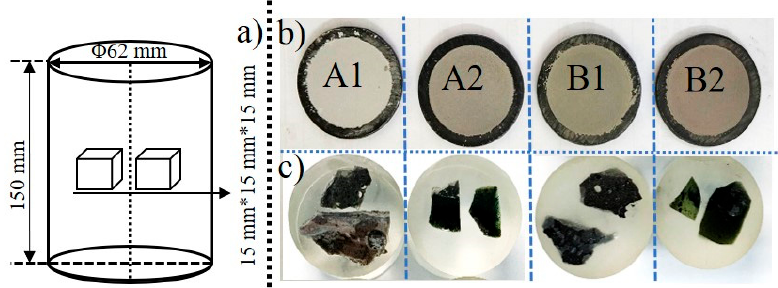
Figure 1. The scheme of obtaining and the appearance of test samples: ( a ) schematic diagram of the metallographic specimen; ( b ) solid tundish covering flux samples ground into powder; ( c ) solid tundish covering flux samples broken into small blocks.